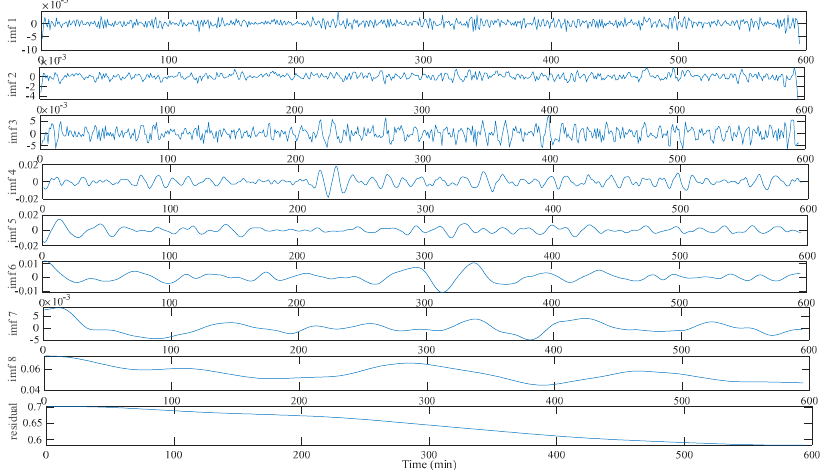
Figure 5. CEEMDAN decomposition of ash accumulation curve.